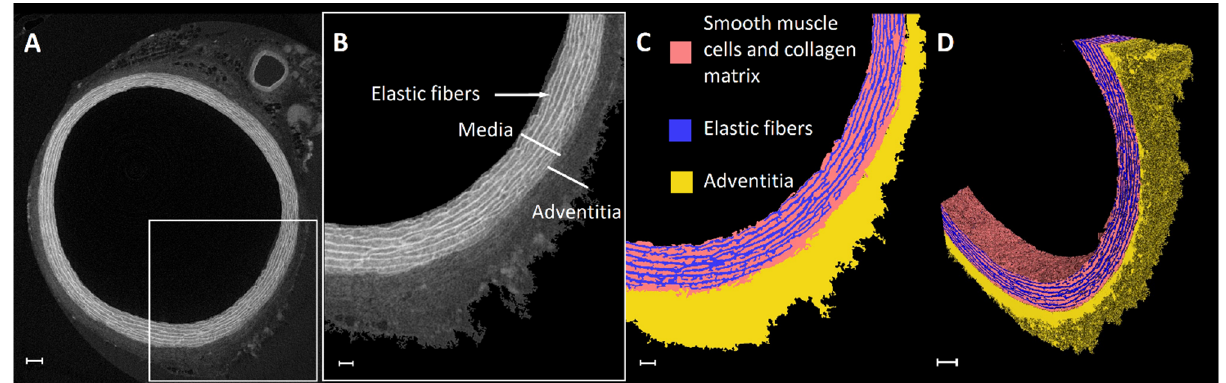
Figure 7. Abdominal rat aorta stained with Hf-WD POM (Appendix A). ( A ) Cross-sectional 2D CE-CT slice, ( B ) ROI selection and segmentation of aortic wall from background with an indication of the substructures, ( C ) segmentation of the media and adventitia and elastic fibers on a 2D ROI slice and ( D ) a 3D view of the segmentation on the ROI of the aortic wall. Scale bars are 100 µm ( A , D ) and 50 µm ( B , C ).